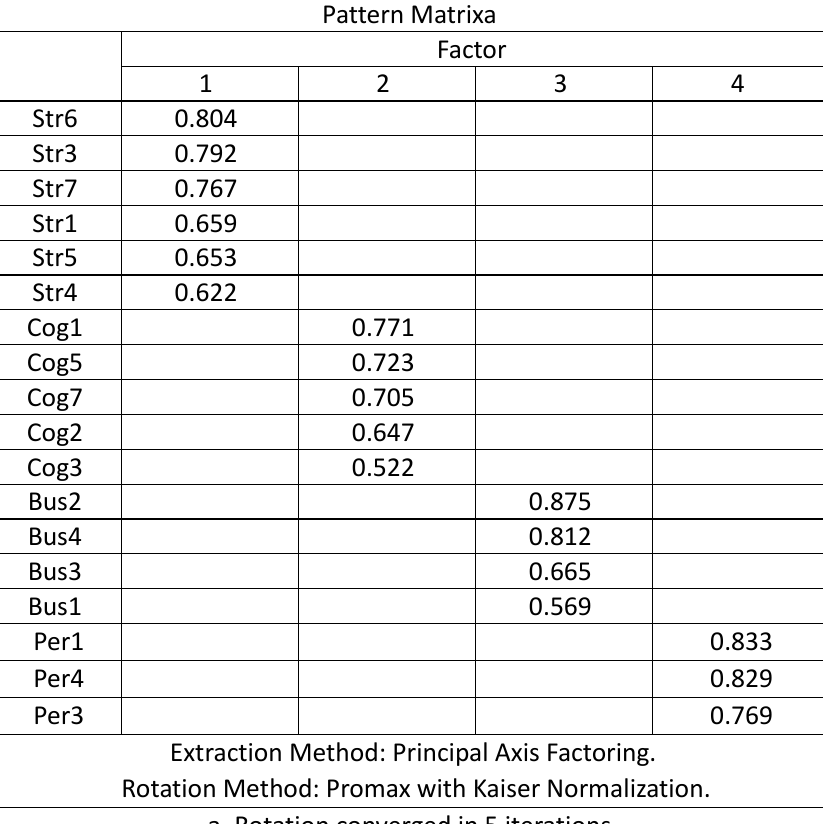
Table 1: Pattern Matrix of EFA